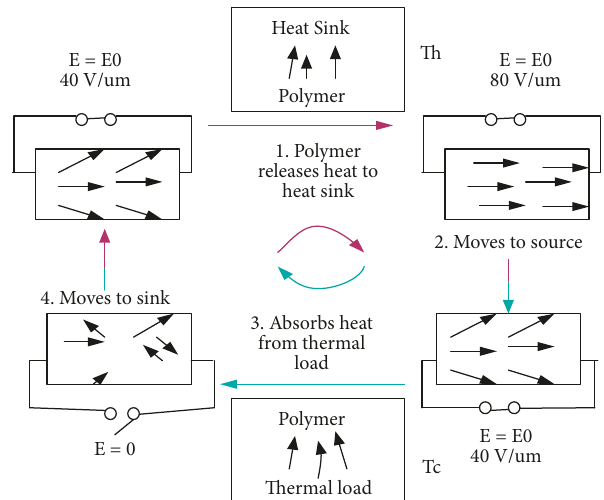
Figure 1: Schematic diagram of the electric card